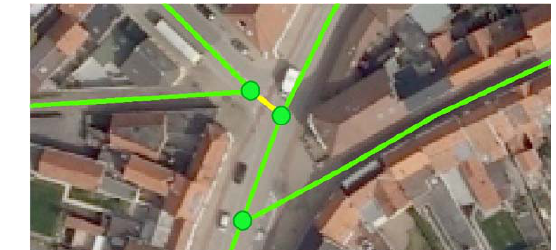
Figure 7: Topologic Analysis: A short road object is not decided by one of the verification modules. According to (correct = green, undecided =